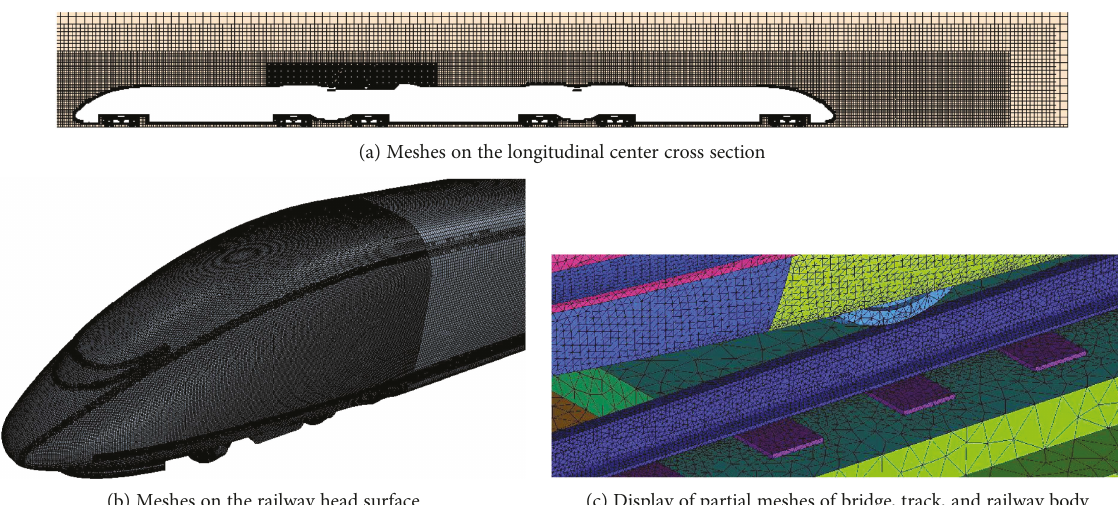
Figure 4: Display of discrete meshes of high-speed railways on